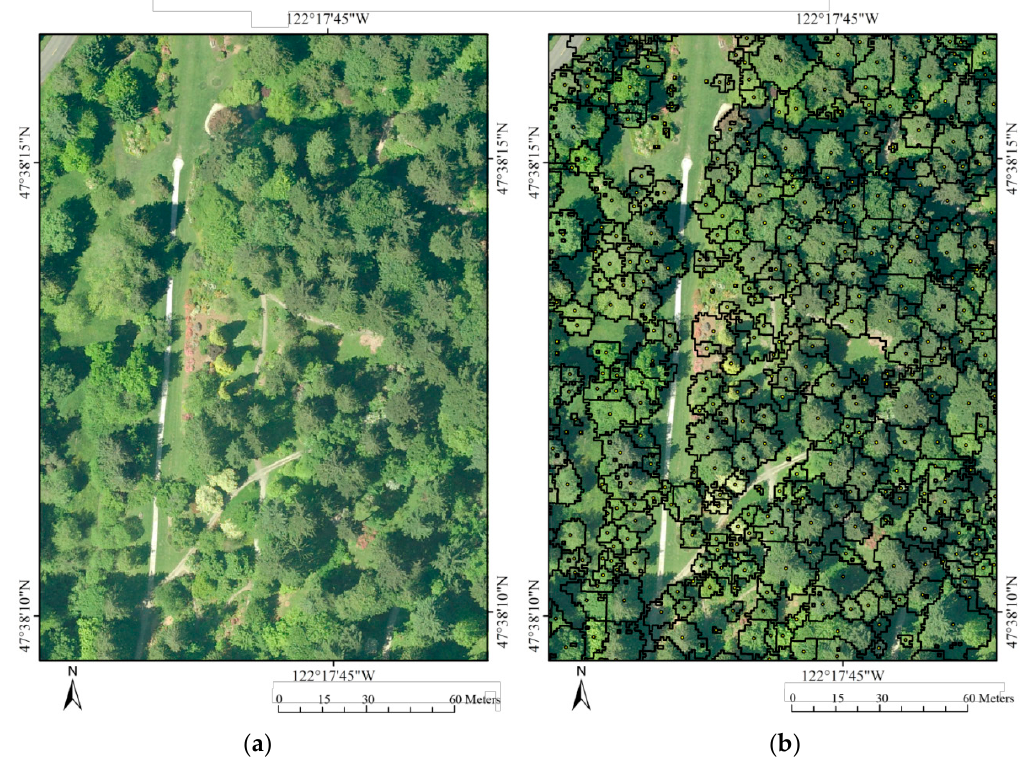
Figure 4. Visualization of segmentation results: ( a ) ortho-imagery with spatial resolution of 0.09 m; and ( b ) overlaying CHM-generated crown segments over the ortho-imagery.